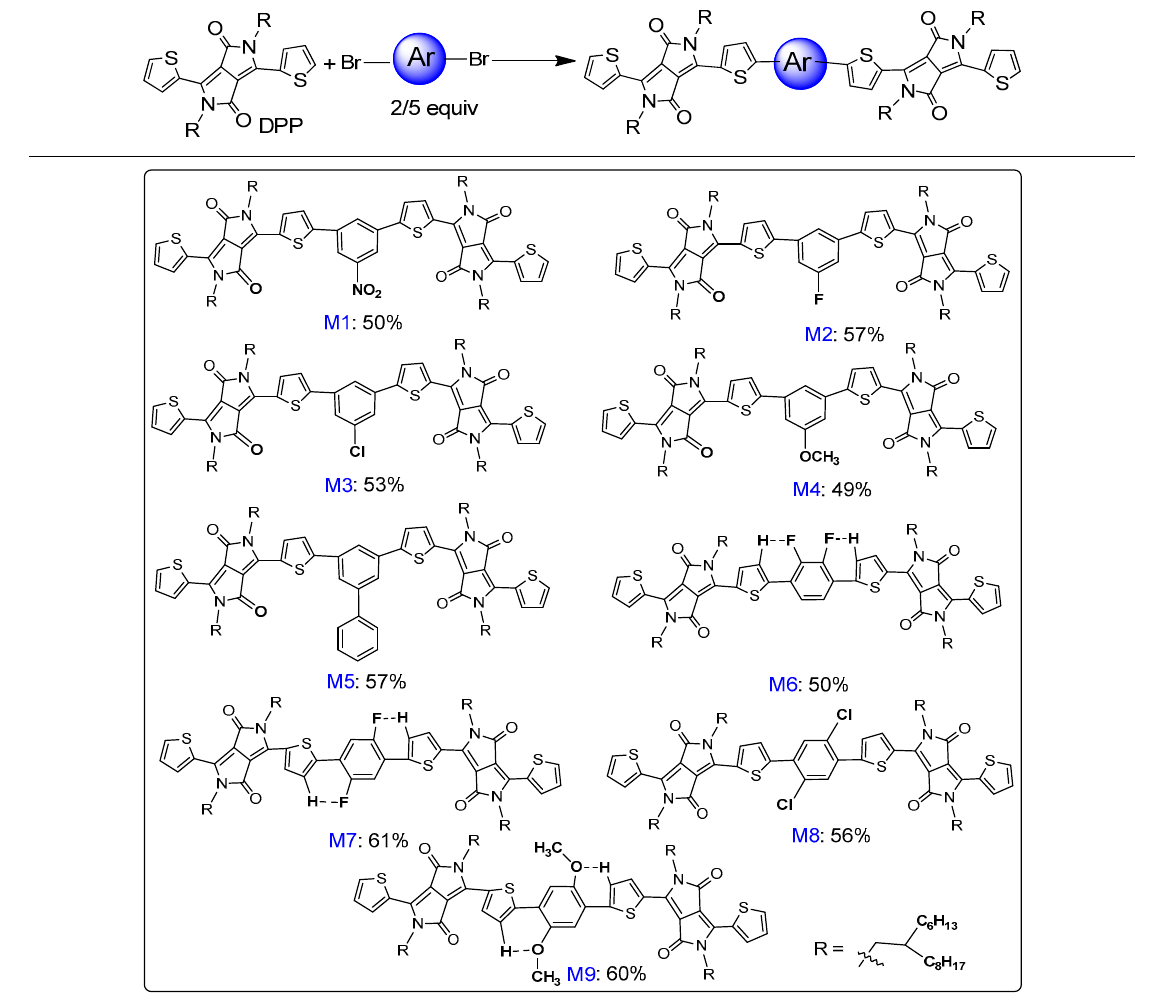
Molecules 2019 , 24 , x FOR PEER REVIEW Table 1. One step synthesis of phenyl-cored DPP molecules (Ms1~9) 1,2 .